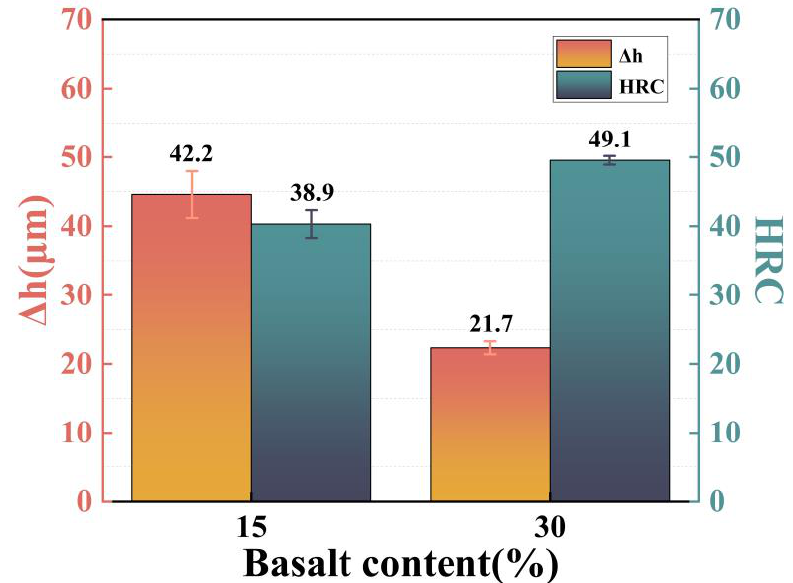
Figure 17. Rockwell hardness test results of Al – basalt powder composite coating.